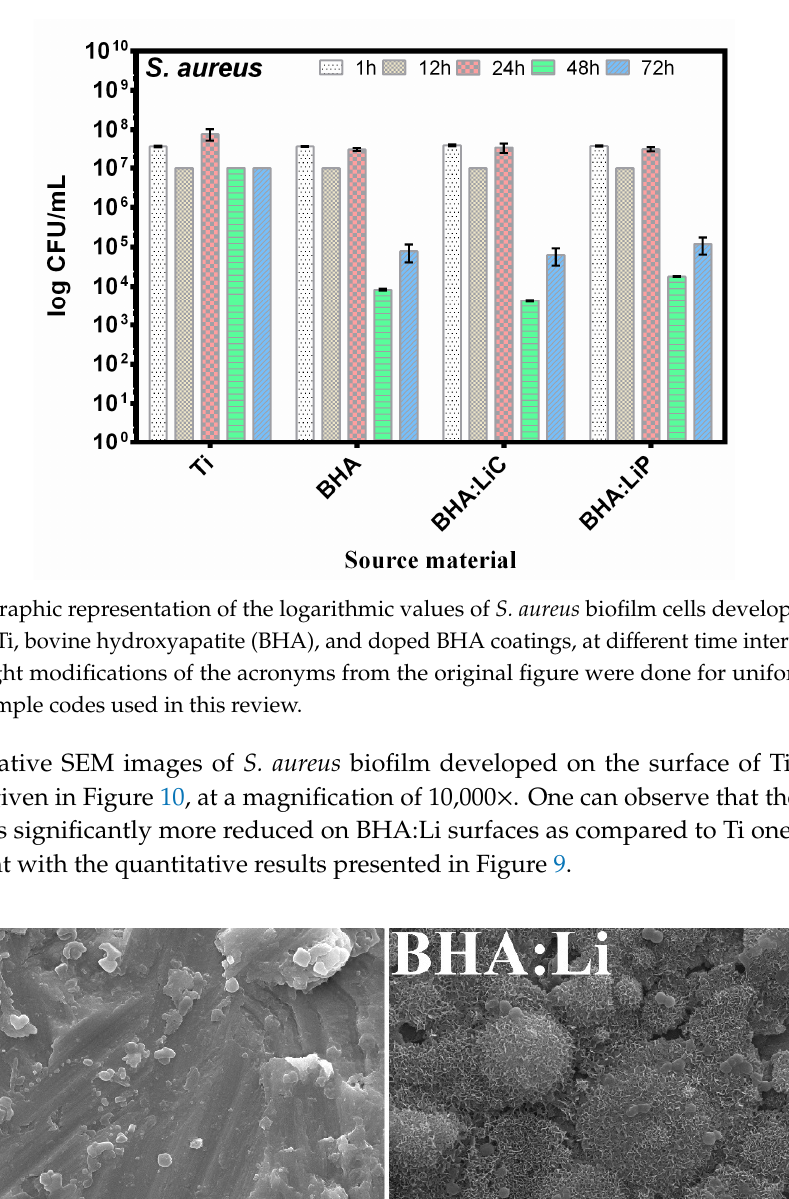
Figure 11. Graphic representation of the logarithmic values of C. albicans biofilm cells developed on the surfaces of Ti, bovine hydroxyapatite (BHA), and doped BHA coatings, at different time intervals (1–72 h) [11]. Slight modifications of the acronyms from the original figure were done for uniformization with the sample codes used in this review.